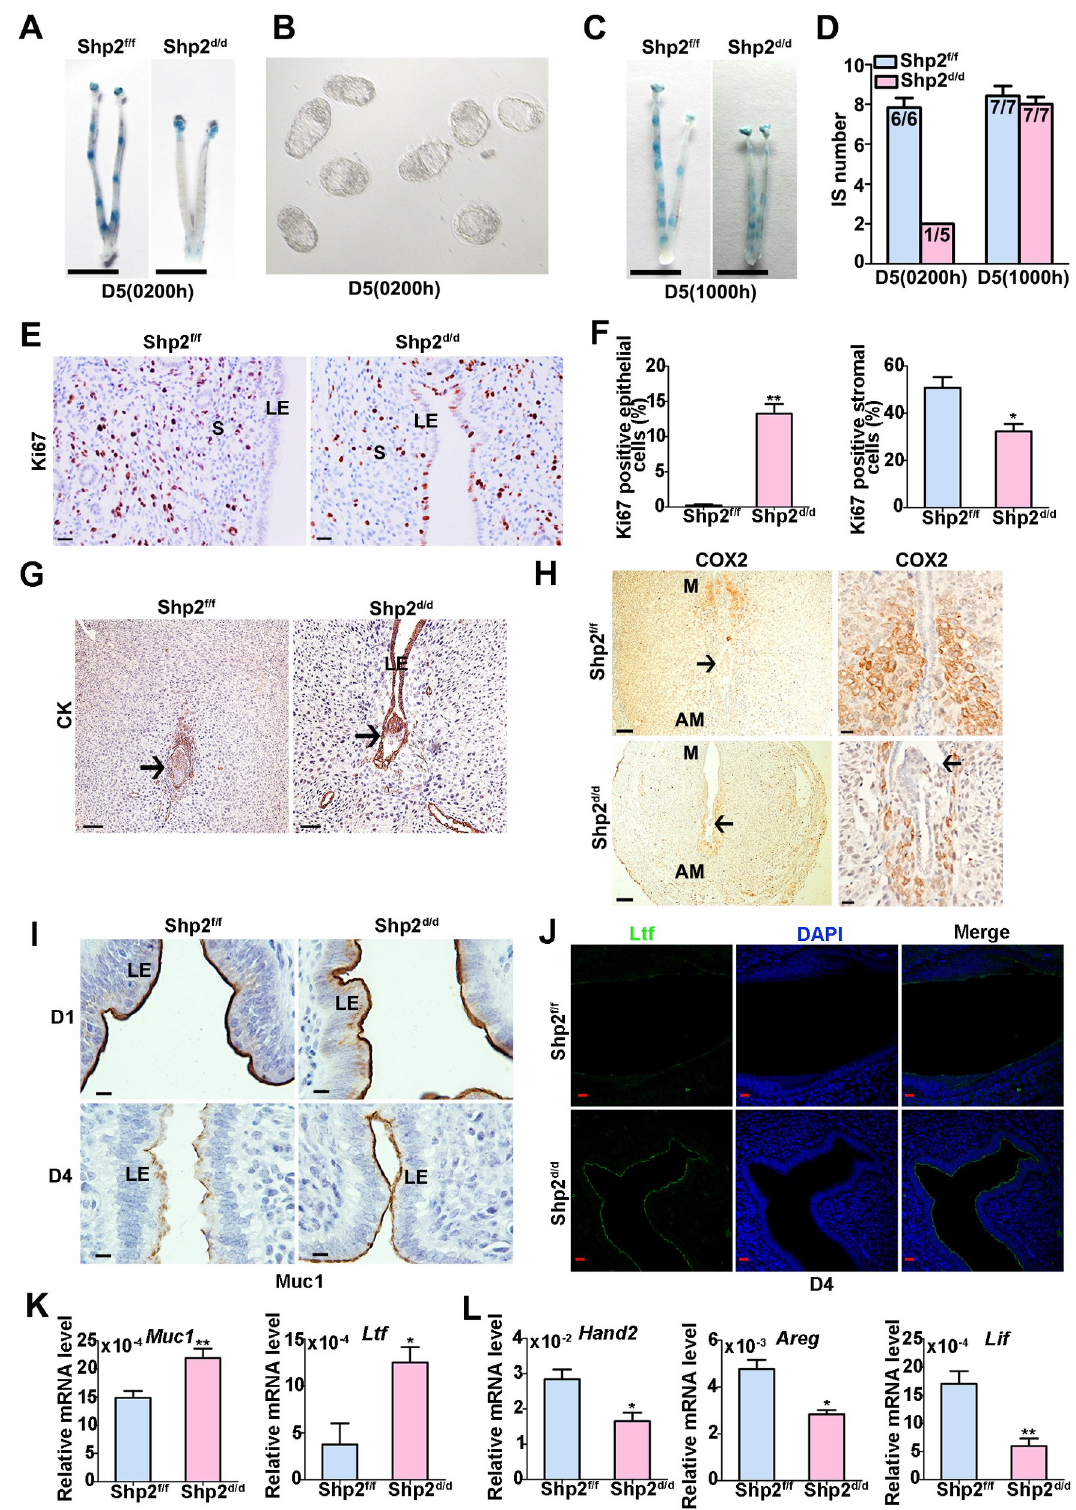
Fig 2. Uterine mesenchymal deletion of Shp2 hampers on-time embryo implantation, disrupts uterine receptivity and defers blastocyst invasion in Shp2 d/d mice. (A) Representative photographs of Shp2 f/f uteri (n = 6) with implantation sites (ISs) and Shp2